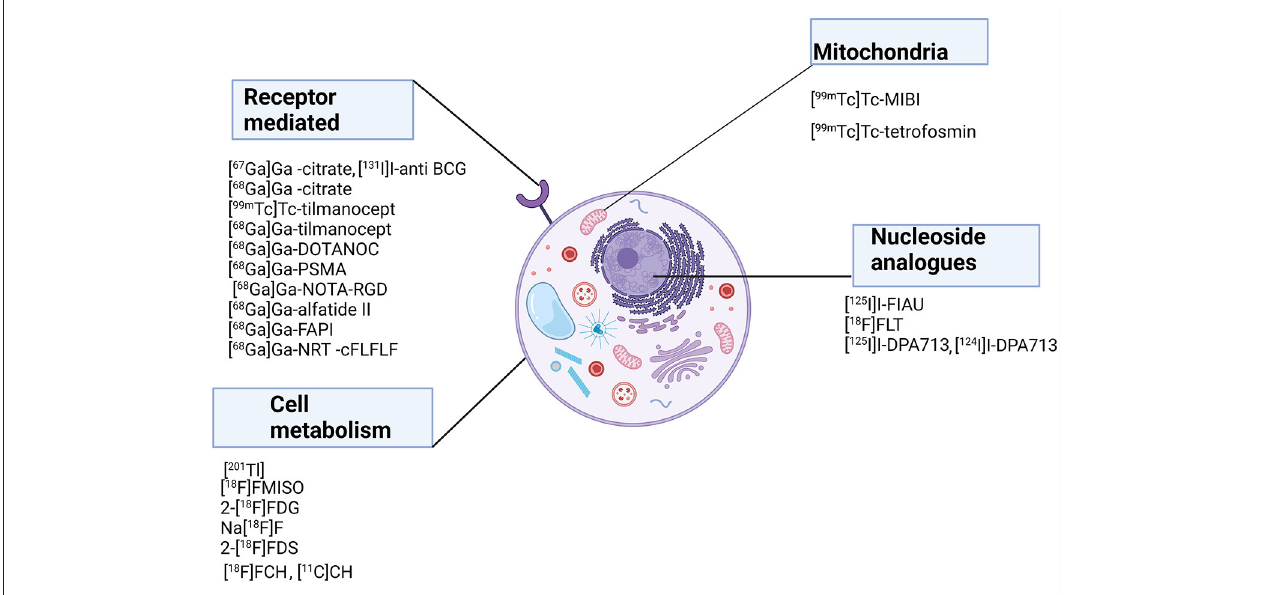
FIGURE 1 | Schematic representation of a host cell and the radiopharmaceuticals listed according to their mechanisms of action.